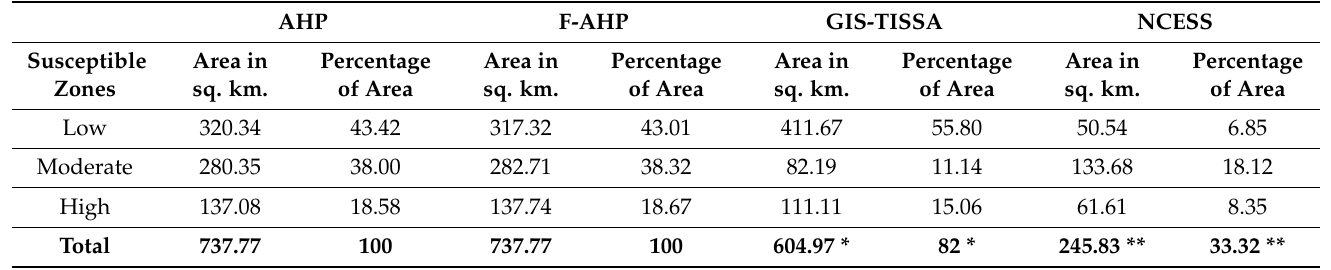
Figure 7. Landslide susceptibility maps. ( a ) AHP, ( b ) F-AHP, ( c ) GIS-TISSA, and ( d ) NCESS. Table 11. Area and percentage of susceptible zones.